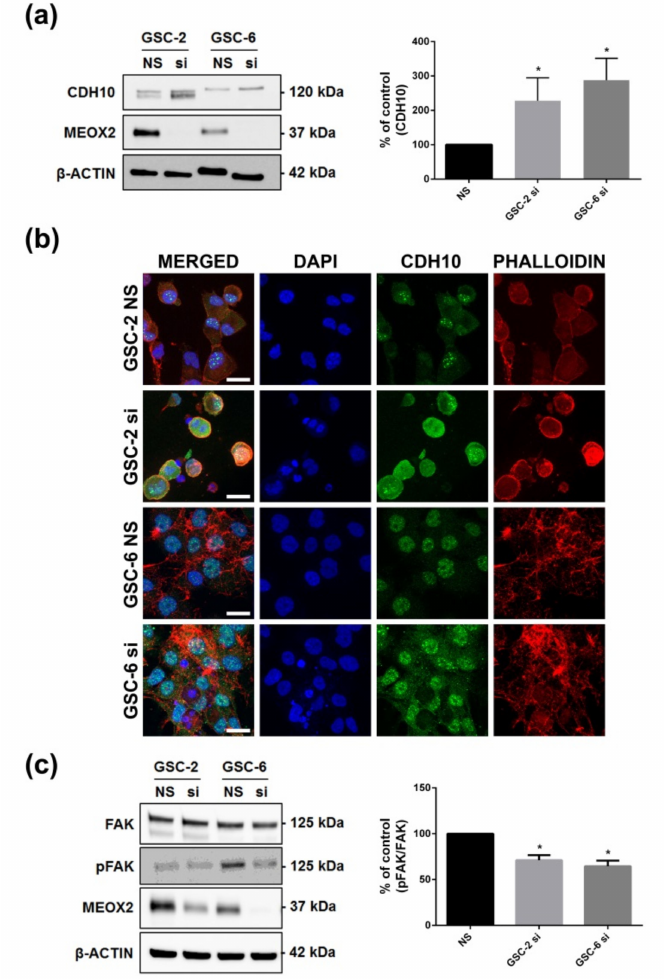
Figure 7. MEOX2 inhibition modifies CDH10 expression and FAK activation. ( a ) Representative WB and histograms of CDH10 after 48 h of MEOX2 inhibition by siRNA1 in GSC-2 and GSC-6 ( n = 4, p < 0.05, Mann–Whitney test); ( b ) Representative immunofluorescence images of the expression of CDH10 (green) after 48 h of MEOX2 knockdown in GSC-2 and GSC-6 (dapi = blue; phalloidin = red; scale bar = 10 µ m); ( c ) Representative WB and histograms of p-FAK/FAK expression after 48 h MEOX2 knockdown (siRNA1) in the GSC-2 and GSC-6 lines cultured under adhesive condition ( n = 4, * p < 0.05, Mann–Whitney